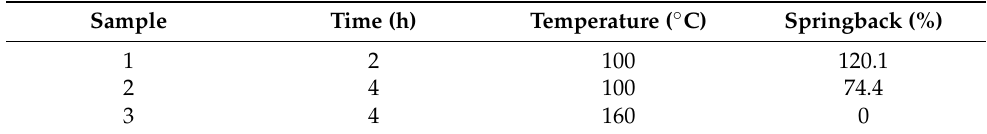
Table 3. Effect of time and temperature on the springback of GLARE-1.